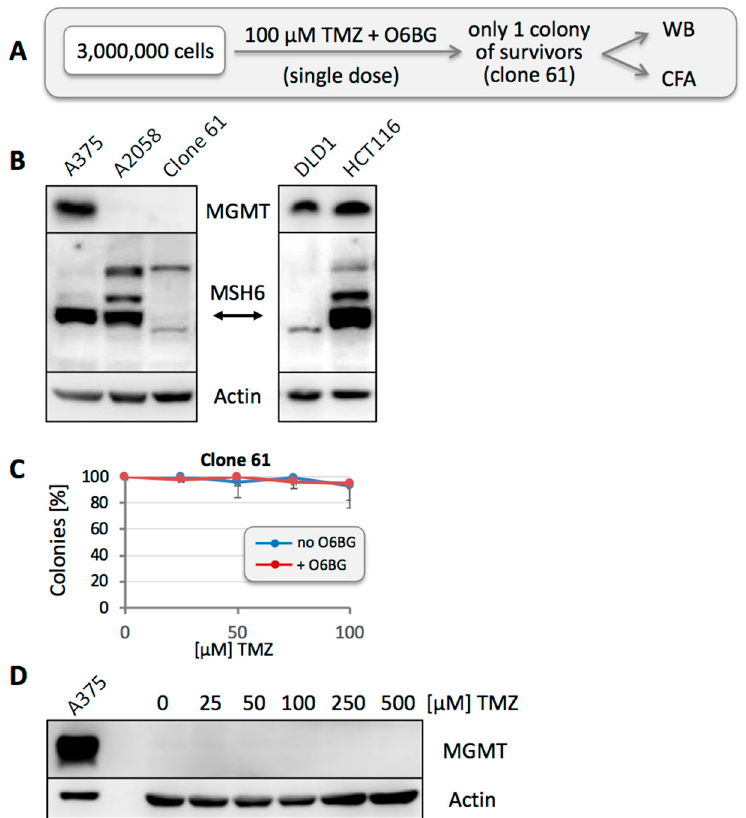
Figure 8. Drug resistance after high-dose TMZ plus O6BG treatment. ( A ) Treatment schedule was as follows: 3 × 10 6 A2058 cells were seeded into a 25-cm plate and treated with 100 µM TMZ in the presence of O6BG. After about 6 weeks, one colony of surviving cells (called clone 61) emerged and was cultured for further analysis by WB and CFA. ( B ) Cell lysate was prepared from clone 61 and analyzed by WB for MGMT and MSH6 protein levels. Lysates from A375 and A2058 cells were included as MGMT-positive and -negative controls, respectively; lysates from HCT116 and DLD1 cells were included as MSH6-positive and -negative controls, respectively. ( C ) To confirm drug sensitivity in correlation with MMR deficiency, clone 61 was treated with increasing concentrations of TMZ in the presence or absence of O6BG, and CFA was performed 12 days later ( n = 3, ± SE). ( D ) Clone 61 was treated with increasing concentrations of TMZ (single dose, as per schedule listed in Figure